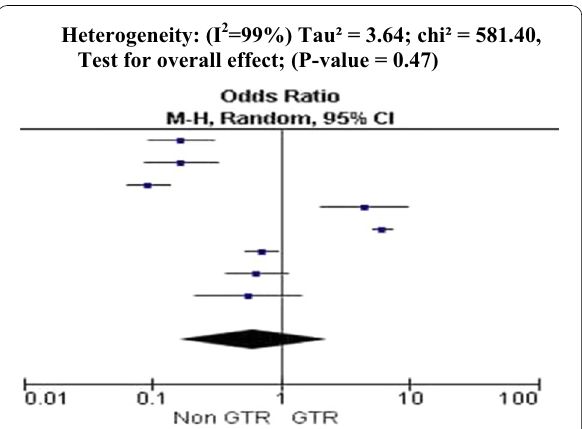
Fig. 2 Forest plot for gross total resection